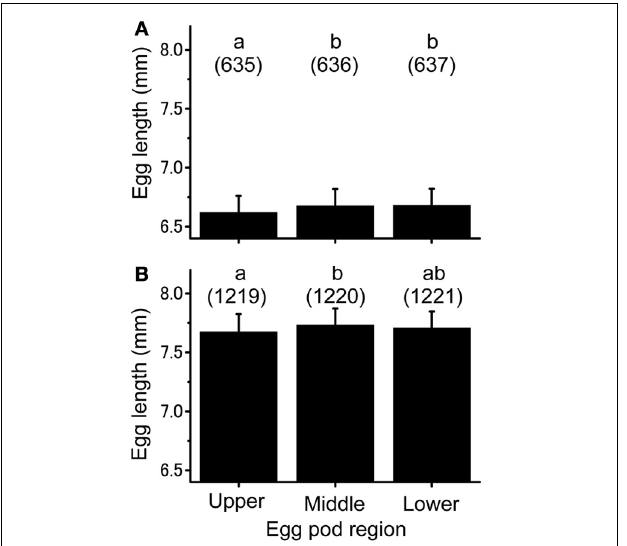
FIGURE 2 | Individual egg size from different regions of the egg pod laid either by the isolation-reared adults (A) or crowd-reared ones (B) of Schistocerca gregaria. Numbers in parentheses indicate sample sizes. Error bars represent standard-deviations. Different letters above each histogram indicate significant differences at P < 0 . 05 by Fisher’s PLSD post-hoc test.